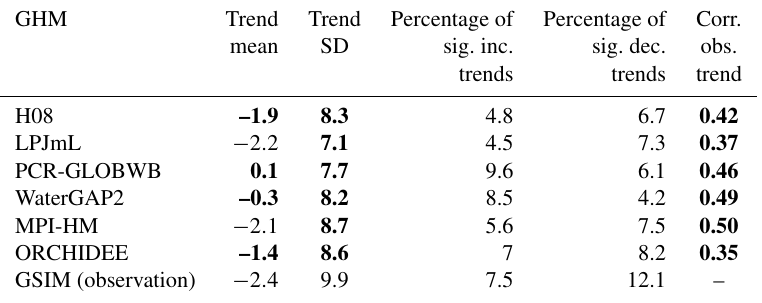
Table 3. Characteristics of trends in the MAX7 index over the 1971–2005 period across 3666 locations for GSIM observed trends and GSWP3 simulated trends (six GHMs available). Trend mean and trend standard deviation are expressed in percentage change per decade. Correlation was obtained from GSIM observed trends and GSWP3 simulated trends for each GHM. Boldface texts represent values that reject the null hypotheses outlined in Table 2 (hypothesis 1 to